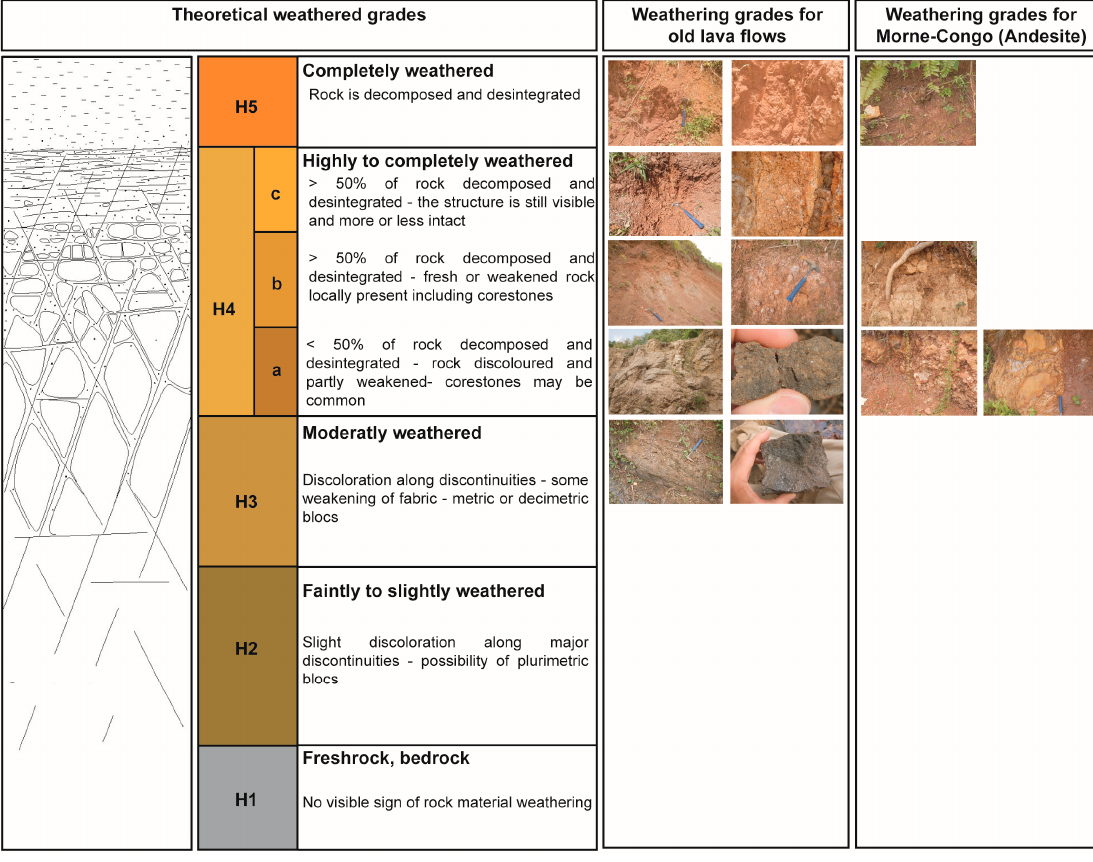
Figure 5. Weathered grades used (adapted from [48,49]).